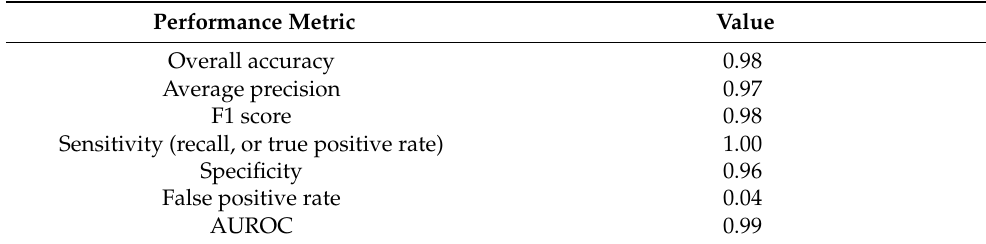
Table 3. Performance metrics for the quadratic discriminant analysis model at a stress incidence threshold of